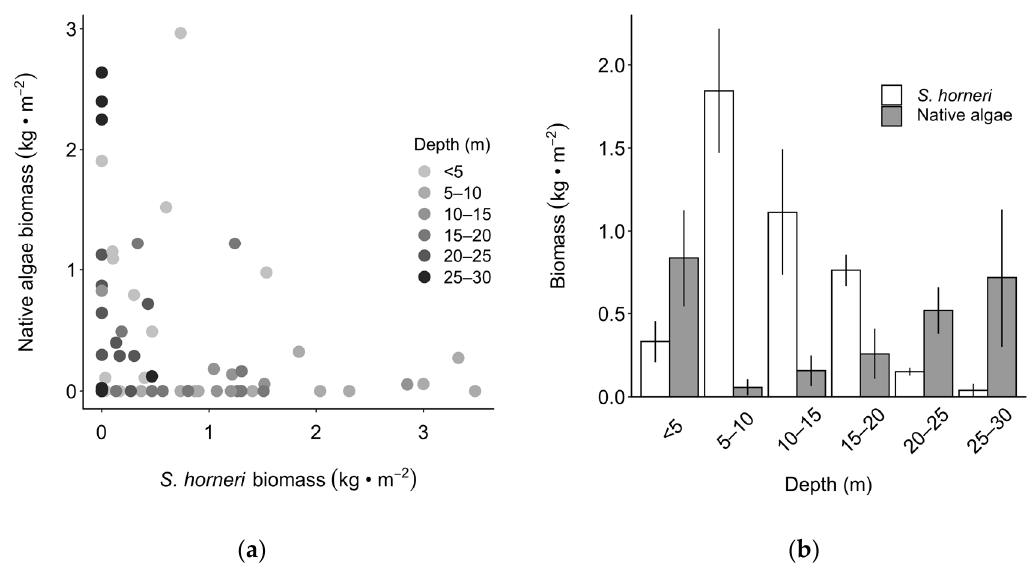
Figure 6. Spatial co-occurrence of Sargassum horneri and native algae. Data are damp biomass of S. horneri and aggregated damp biomass of all native algae measured within 1 m 2 quadrats sampled along transects running perpendicular to shore. ( a ) Points represent individual quadrats, and are shaded by depth bin. N = 64 quadrats sampled across 4 sites. ( b ) Bars represent mean (± SE) biomass of S. horneri (white) and the native algae (grey) by 5 m depth bins. The mean and SE of individual species is provided in Table S4. N = 4 sites per depth bin except 25–30 m where N = 3 sites.